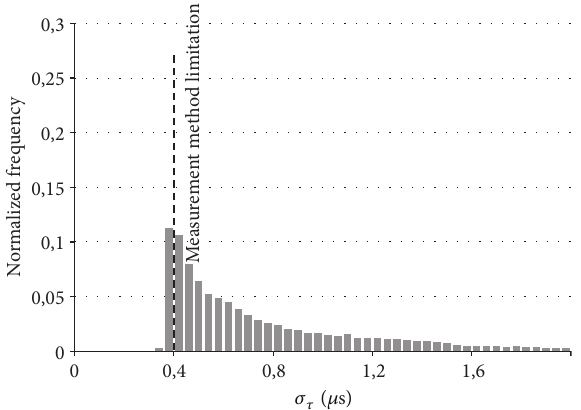
Figure 5: Histogram of rms delay spread values measured in city area.